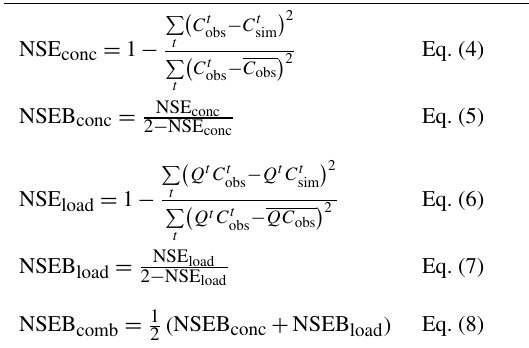
Table 3. Numerical criteria used for optimization ( C obs – observed concentration, C sim – simulated concentration, Q – observed dis- charge). The Nash and Sutcliffe (1970) efficiency (NSE) criterion is well known and widely used in the field of hydrology. The rescal- ing proposed by Mathevet et al. (2006) transforms NSE into NSEB, which varies between − 1 and 1 (its optimal value). The advantage of this rescaled version is to avoid the occurrence of large negative values (the original NSE criterion varies in the range [ −∞ , 1]).